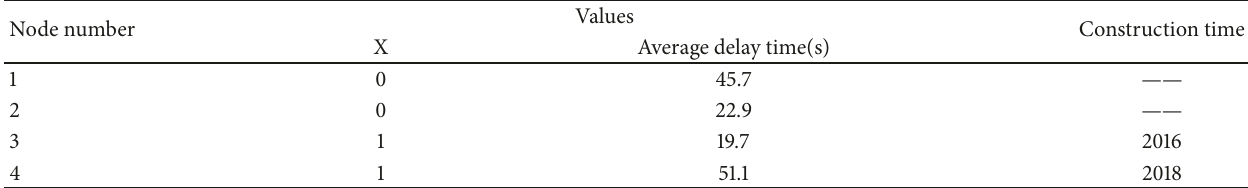
Table 5: Results of simulation-based optimization model.